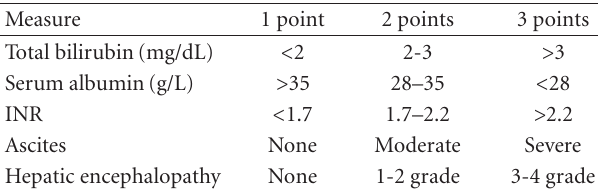
Table 1: Child-Pugh scores for diagnostic hepatitis virus.